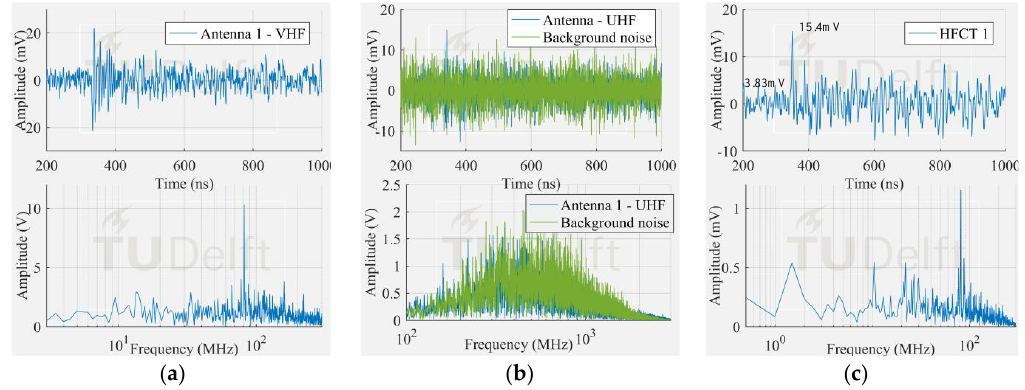
Figure 11. Smallest free moving particle signal measured by ( a ) antenna 1 in VHF; ( b ) antenna 1 in UHF; ( c ) HFCT 1.